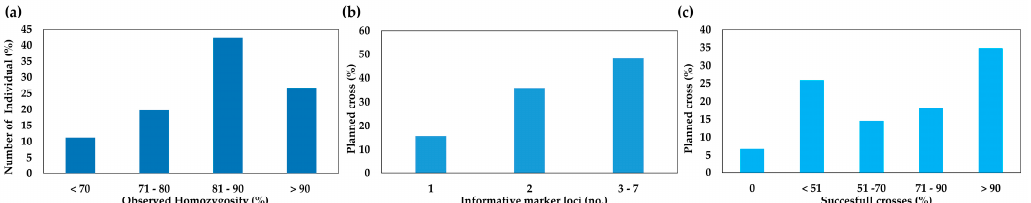
Figure 3. ( a ) Observed homozygosity of 71 lettuce parental individuals belonging to as many pure lines. ( b ) Histogram of discriminating loci in 89 cross combinations (in percentages). ( c ) Histogram of the percentages of pollination success in 89 programmed lettuce crosses.